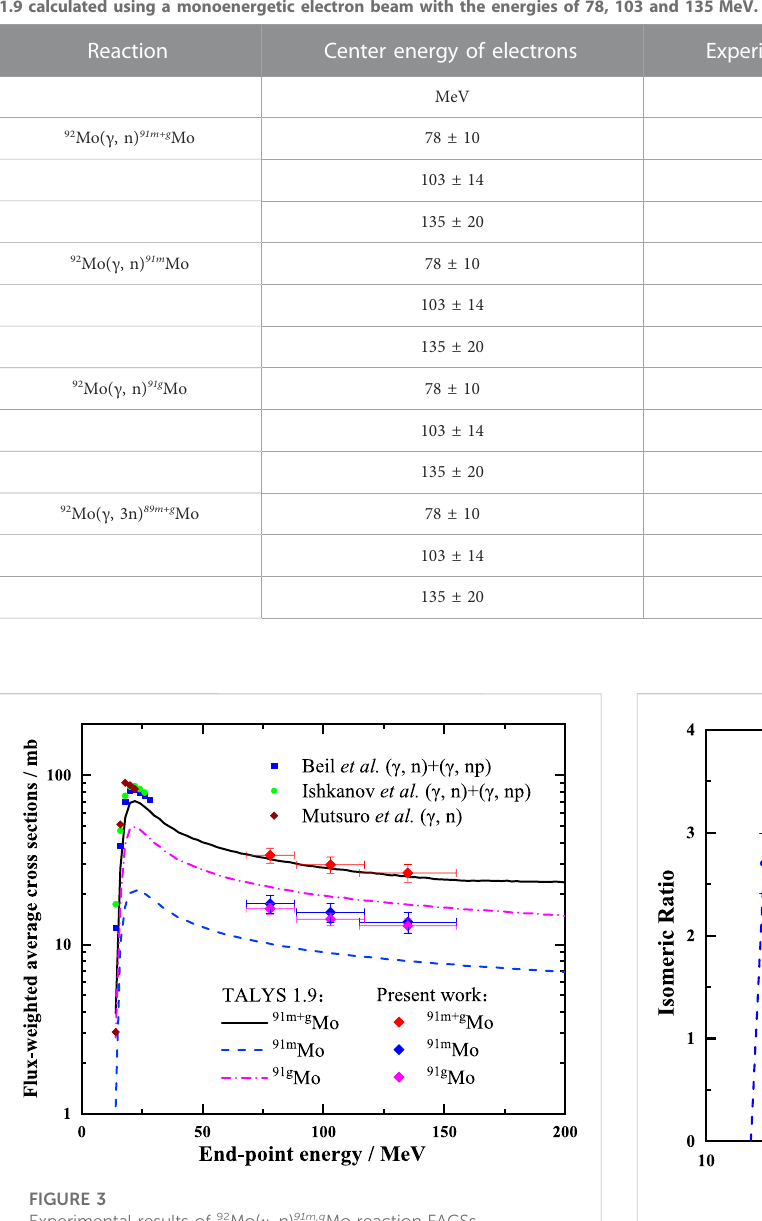
FIGURE 4 Experimentalresults of 92 Mo( γ , n) 91m,g Mo reaction IRs, comparing with previous works [31, 34 – 39] and TALYS 1.9